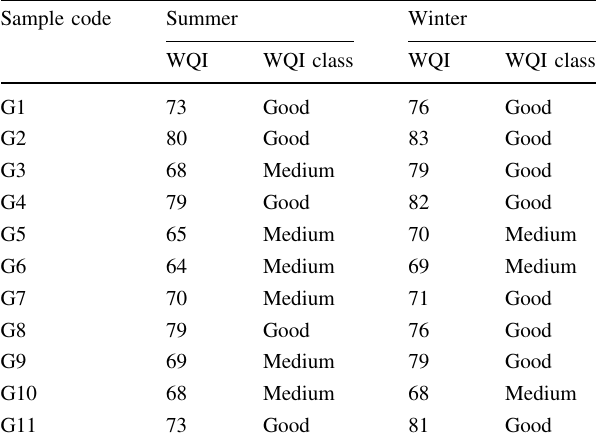
Table 9 WQI of groundwater resources of the study area sampled during summer and winter 2012–2013 Sample